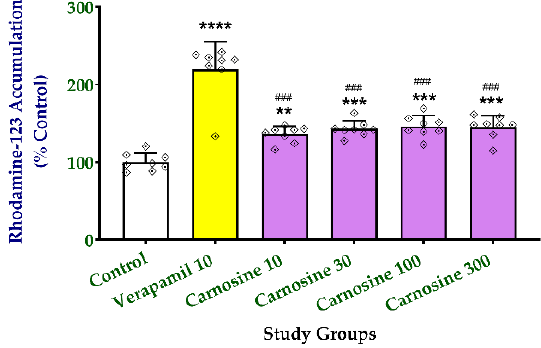
Figure 6. Carnosine inhibits P-glycoprotein activity in vitro and decreases the efflux of rhodamine- 123. The rhodamine-123 efflux assay was carried out on NCI/ADR-RES cells as described in Meth- ods. Cells were incubated with rhodamine- 123 (1 μM) for one hour in the absence (white bar) or presence of 10 μM verapamil (yellow bar) or increasing concentrations of carnosine (10 – 300 μM, purple bars). Data (mean ± SD, n = 8) represent the % rhodamine-123 accumulated inside the cells relative to untreated controls. Data were analyzed with one-way ANOVA followed by the Tukey test for comparison between groups. **, ***, **** indicate significant differences from control cells at p < 0.01, 0.001, and 0.0001, respectively; ### indicates significant differences from the verapamil- treated cells at p <